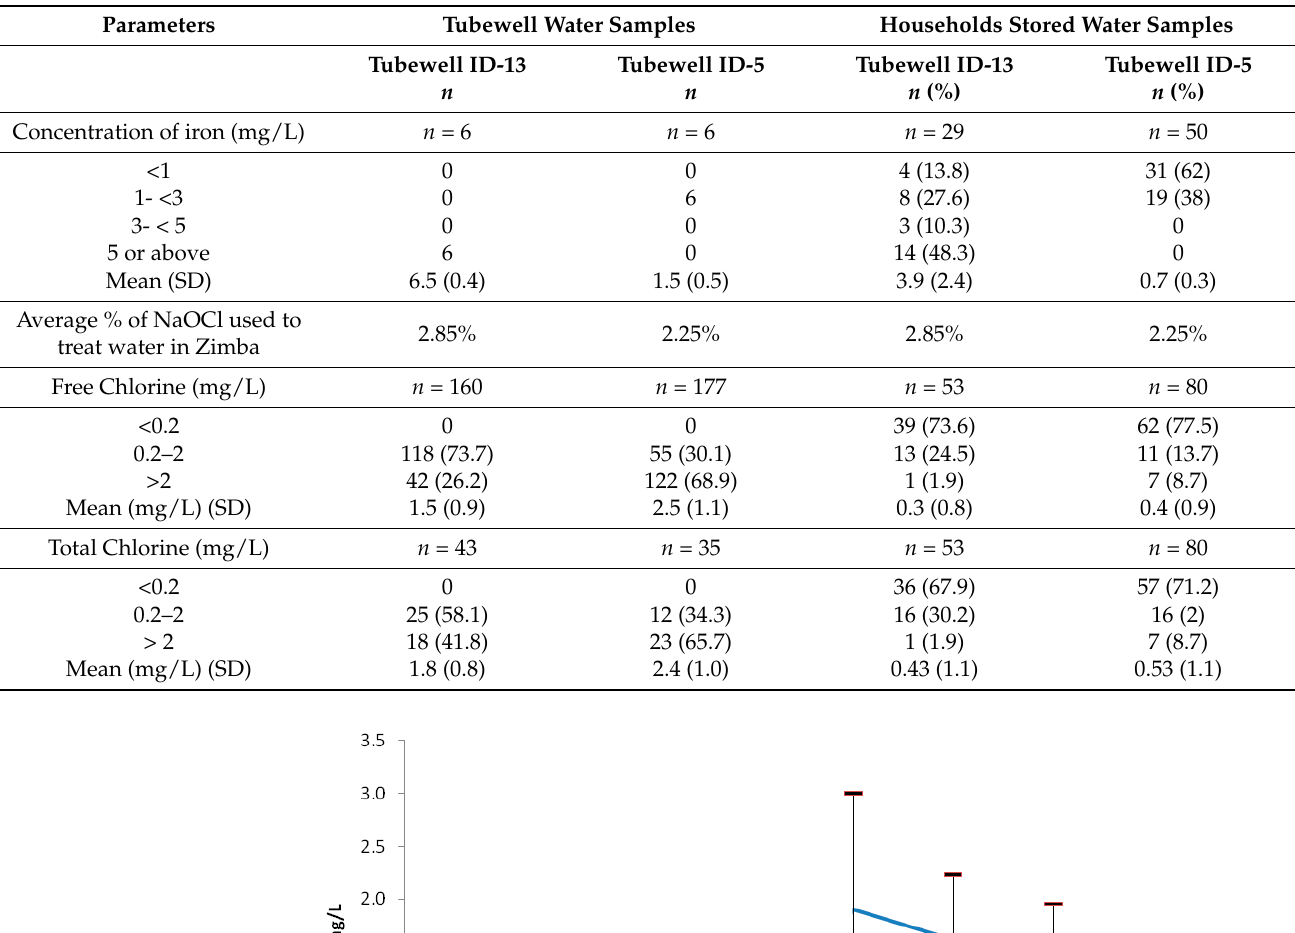
Table 4. Water characteristics for intervention tubewells and household stored water.